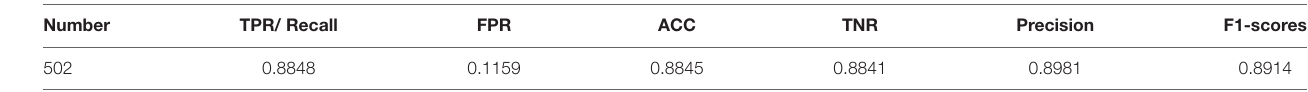
TABLE 4 | Summary results of the model in diagnosing types of benign paroxysmal positional vertigo (BPPV). Number TPR/